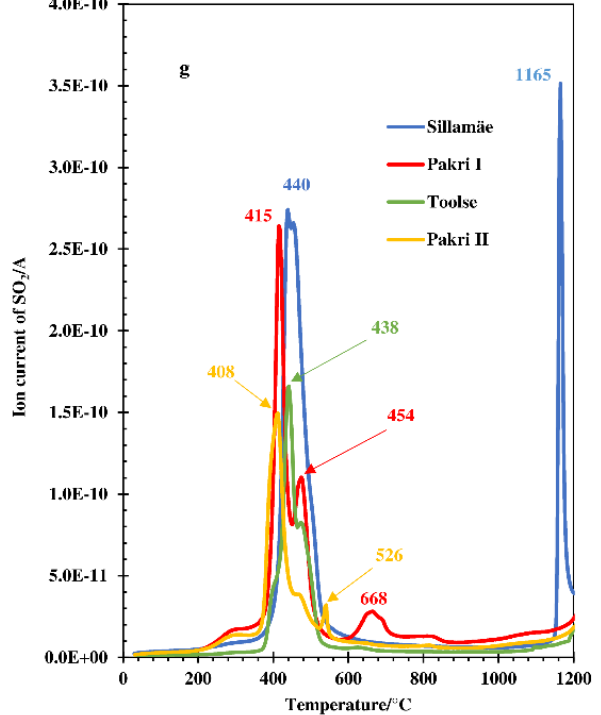
Figure 3. Emission profiles of H 2 O ( a ), CO 2 ( b ), NOx ( c ), hydrocarbon fragments with m / z = 27 ( d ), m / z = 45 ( e ), m / z = 15 ( f ), and SO 2 ( g ) emitted at thermal treatment of GA samples.